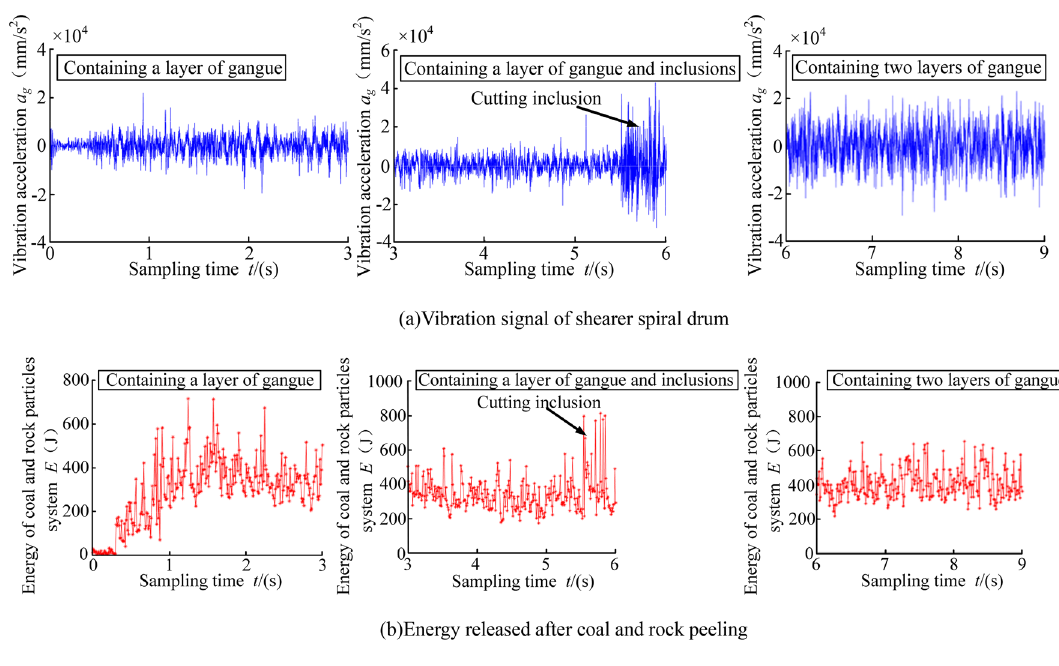
Figure 15. Real-time updated data information.